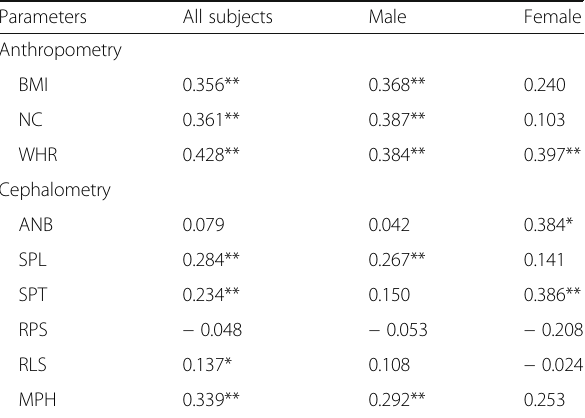
Table 3 Correlation of anthropometric and cephalometric parameters with